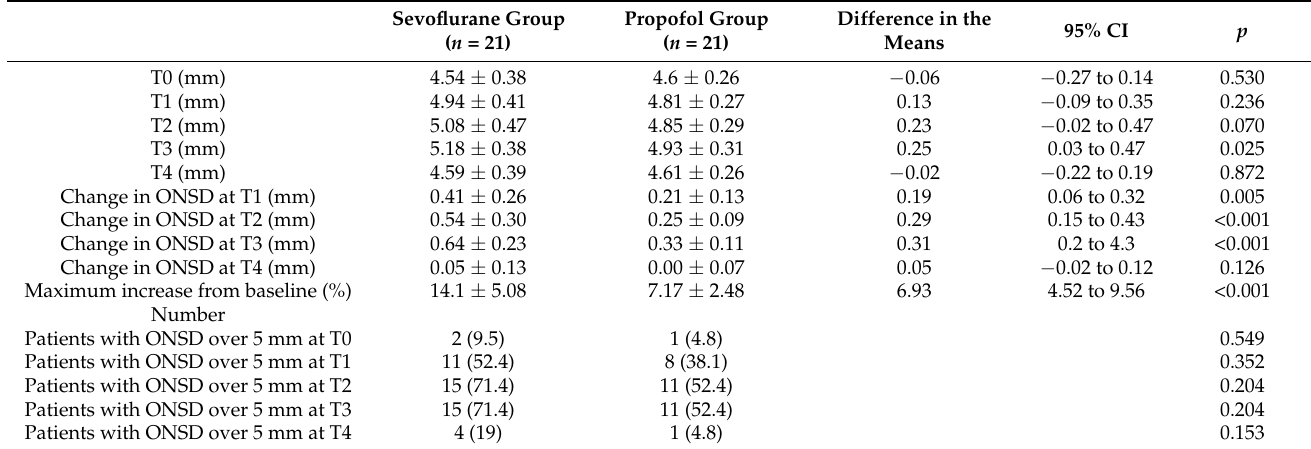
Table 2. Comparison of change in ONSD between two groups.